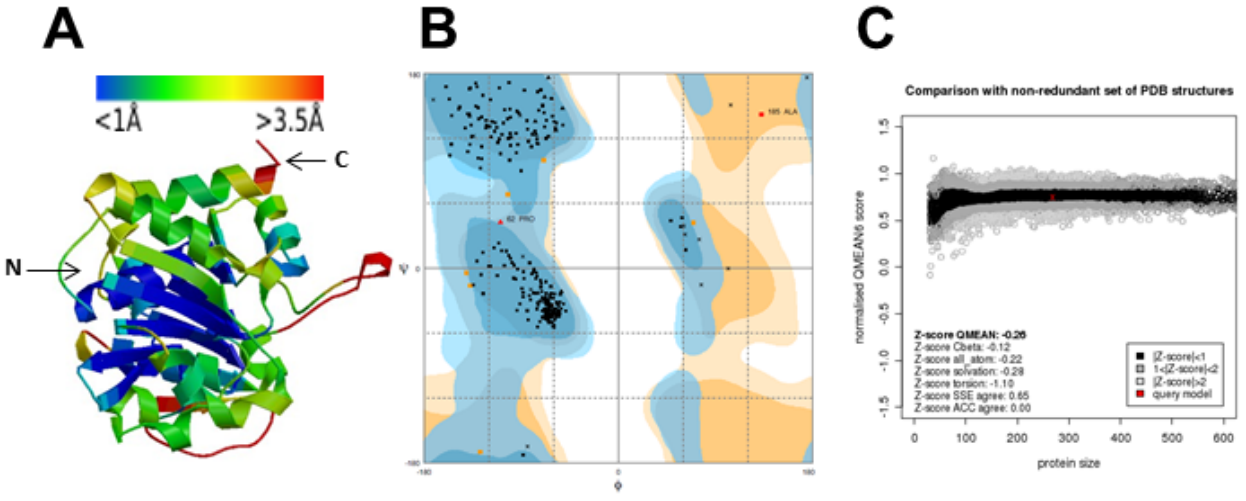
Figure 3. ( A ) 3D model of SaSDH in ribbons colored by per-residue inaccuracy (the N- and C- terminals are indicated with arrows); the upper bar shows the corresponding deviation according to the color. The SHK binding site is located in the blue region. ( B ) Ramachandran plot obtained from model protein geometry evaluation (dark blue, light blue, and orange correspond to the favored, allowed and outlier regions respectively). ( C ) Normalized QMEAN6 score graphic showing the position (red cross) of the model in the set of PDB structures used for the evaluation and the Z-score